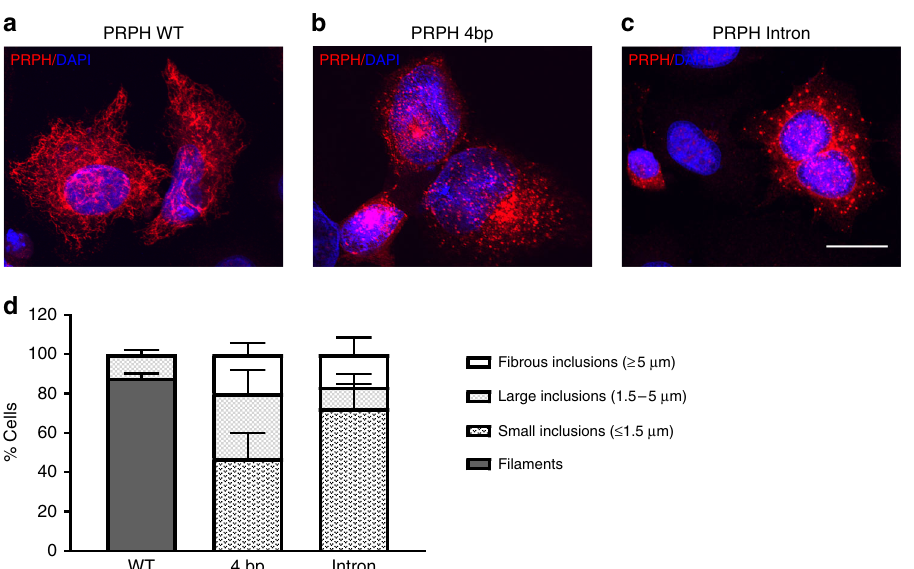
Fig. 5 Truncated PRPH variants generate protein inclusions. SW13 cells were transfected with a wild-type ( PRPH WT) using n = 332 cells, b 4bp-splice variant ( PRPH 4 bp) using n = 545 cells, or c intron retention splice-variant ( PRPH Intron), cultured for 48 h and labeled with an antibody raised against peripherin and counterstained with DAPI (4 ′ ,6-diamidino-2-phenylindole) for nuclear visualization, using n = 177 cells. Scale bar represents 10 µ m. d Peripherin fi laments and inclusions were quanti fi ed from the three independent experiments ( n = 177 – 545). Inclusions were subdivided by size; fi brous inclusions ≥ 5 µ m, large inclusions 1.5 – 5 µ m, and small inclusions ≤ 1.5 µ m ( n = 177 – 545). Error bars represent standard deviations